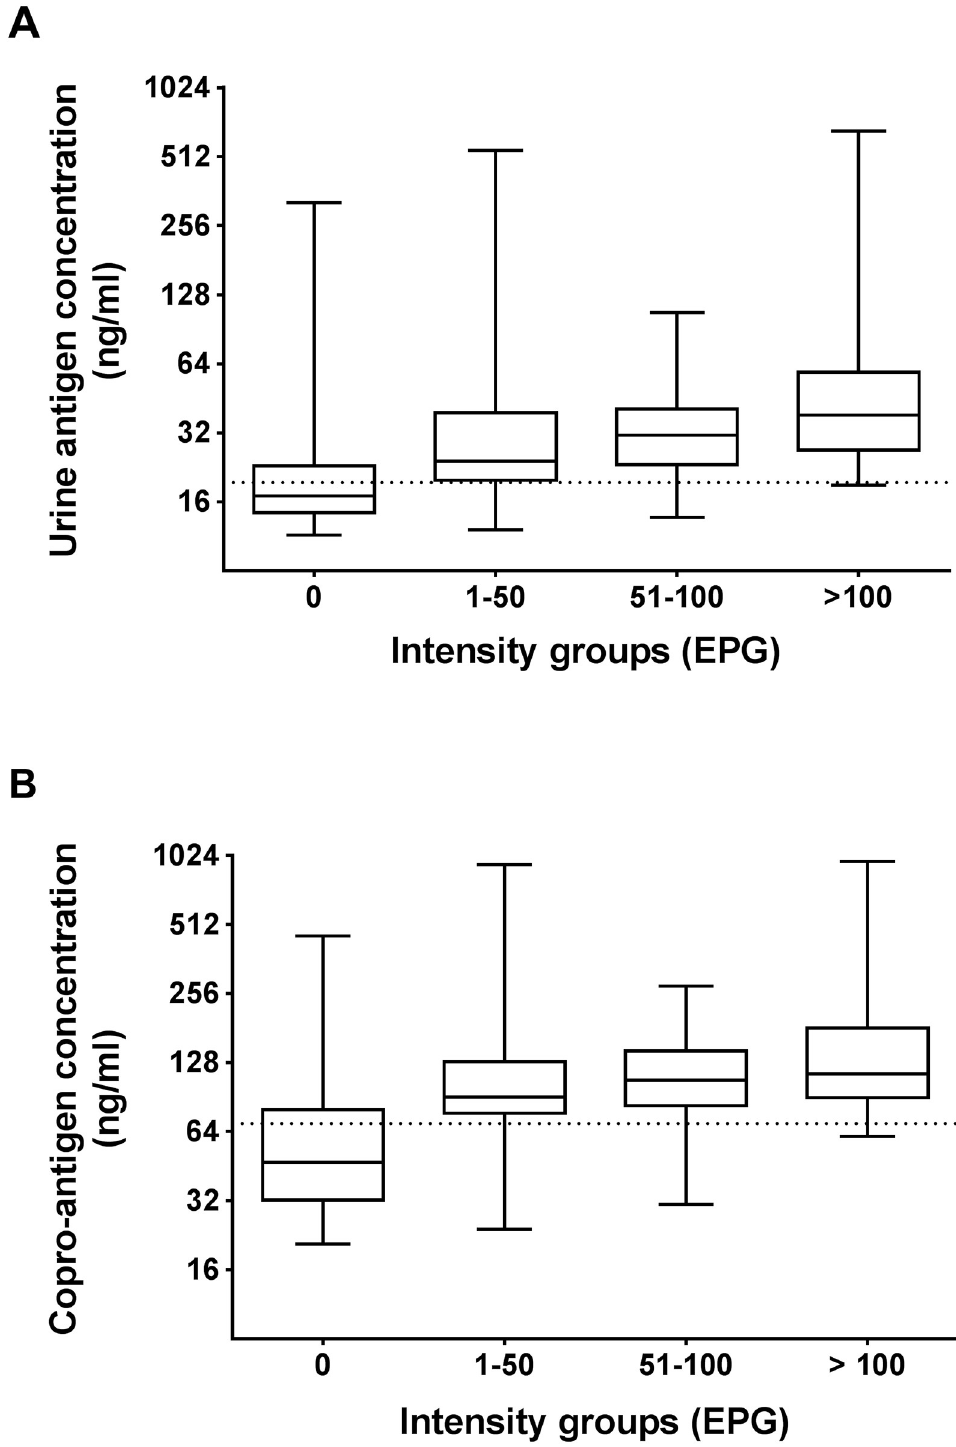
Fig 3. Relation between O . viverrini antigen levels and intensity of O . viverrini (EPG). (A) The profiles of urine antigen levels (ng/ml) in different intensity groups of O . viverrini (EPG) (Kendall’s tau-b correlation; P < 0.001); (B) The profiles of copro-antigen levels (ng/ml) in different intensity groups of O . viverrini (EPG) (Kendall’s tau-b correlation; P < 0.001).